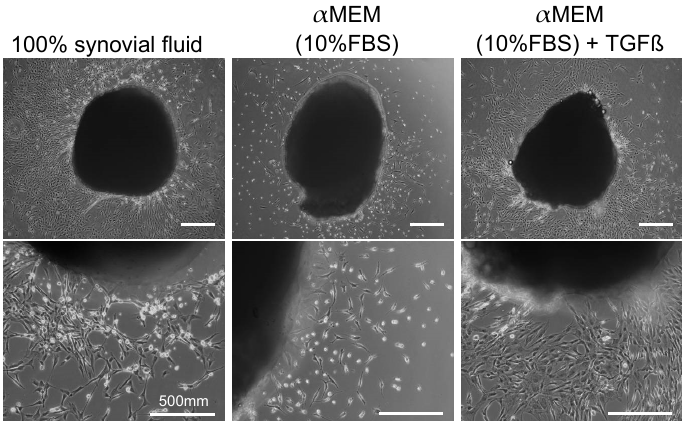
Figure 3. Morphology of an explant culture of synovium. Synovial tissues were cultured for 8 days in autologous synovial fluid, α MEM (10%FBS), or α MEM (10%FBS) with 10 ng/mL of TGF β (reproduced from [10]).